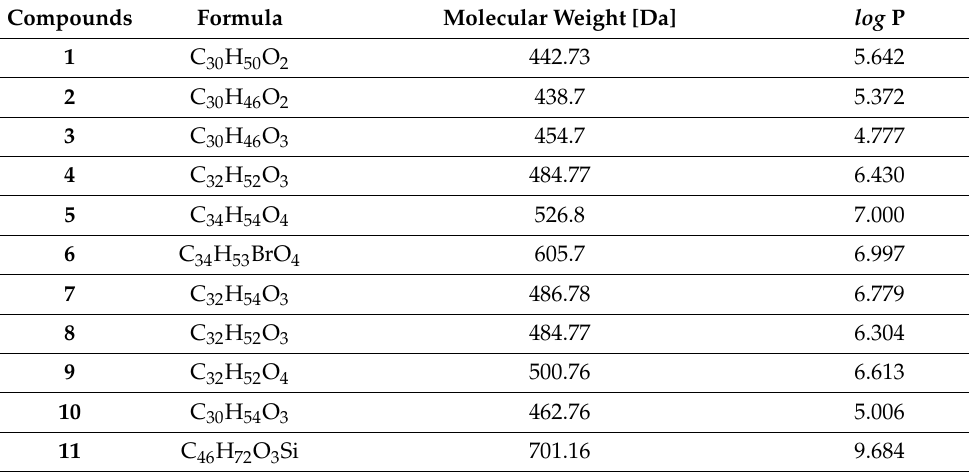
Table 1. Partition coefficient values calculated by theoretical method, in the MestReNova program. Compounds